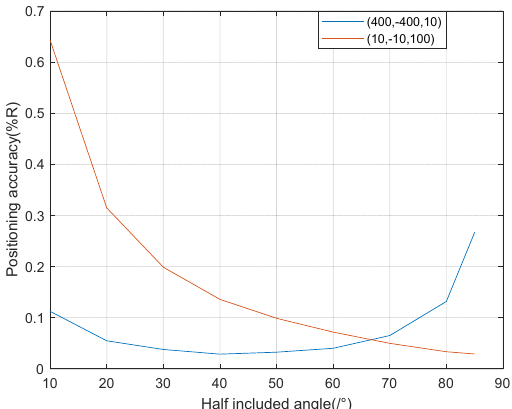
Figure 8. Positioning accuracy of stereo array 2 at different half - included angle.